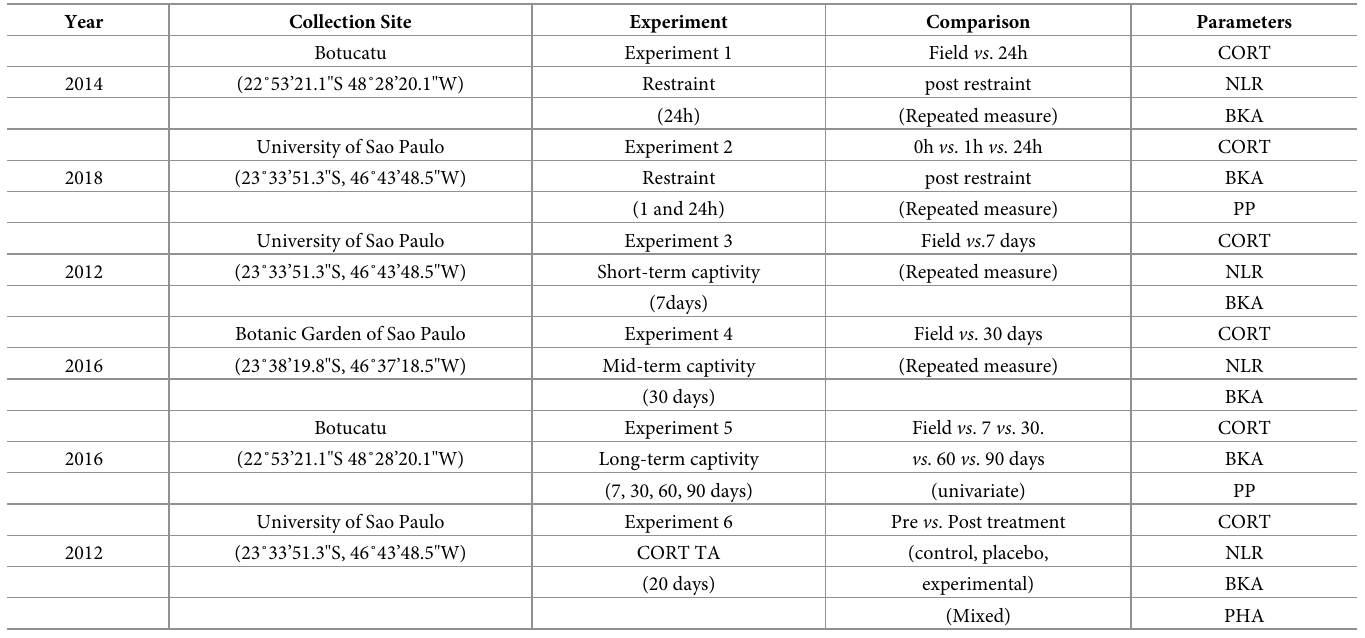
Table 2. Detailed information regarding year of collection and experimental procedures, statistical comparisons and studied parameters of R . ornata